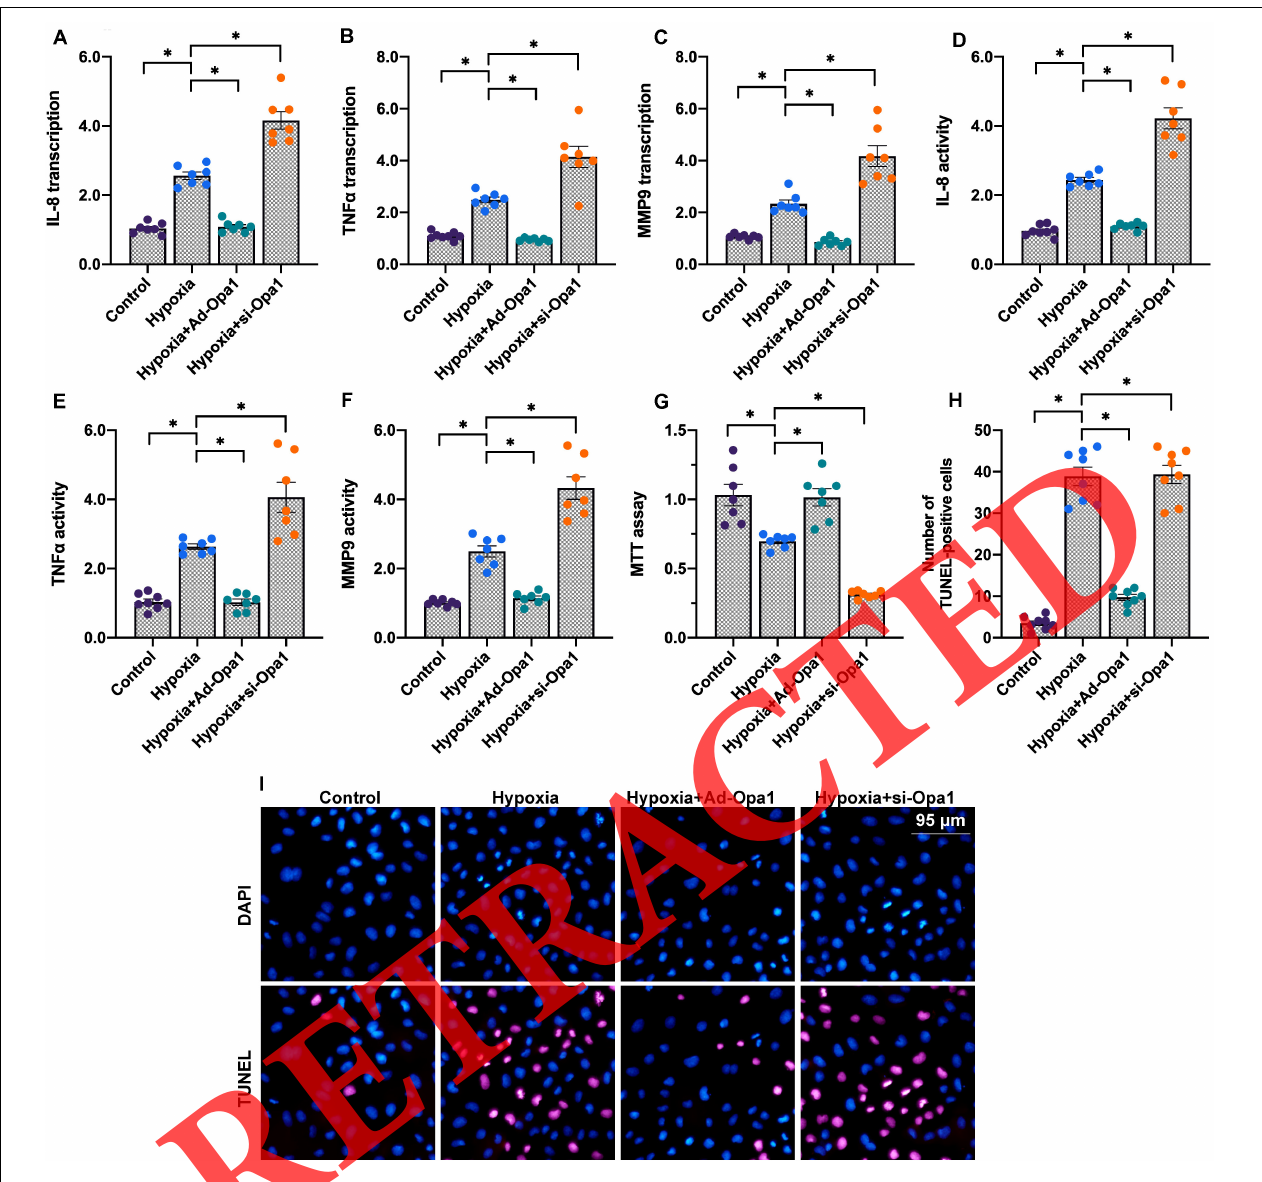
FIGURE 2 | Opa1 reduces cardiomyocyte inflammation and apoptosis. (A–C) Analysis of IL-8, TNF α , and MMP9 expression through qPCR. (D–F) ELISA analysis of IL-8, TNF- α , and MMP-9 secretion. (G) MTT viability assay results. (H,I) Apoptosis assay results. TUNEL staining was applied to quantify the number of apoptotic cardiomyocytes following hypoxic stress. ∗ p <